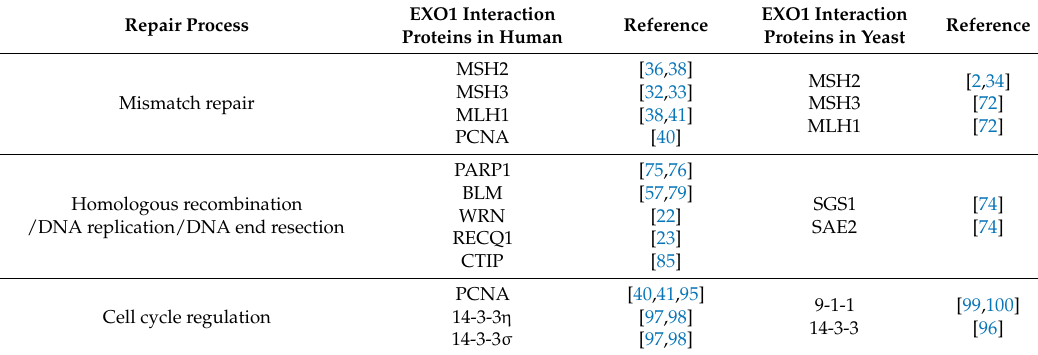
Table 1. EXO1 interactor proteins in humans and yeast. Significant interaction partners of EXO1 in humans and yeast during different cellular